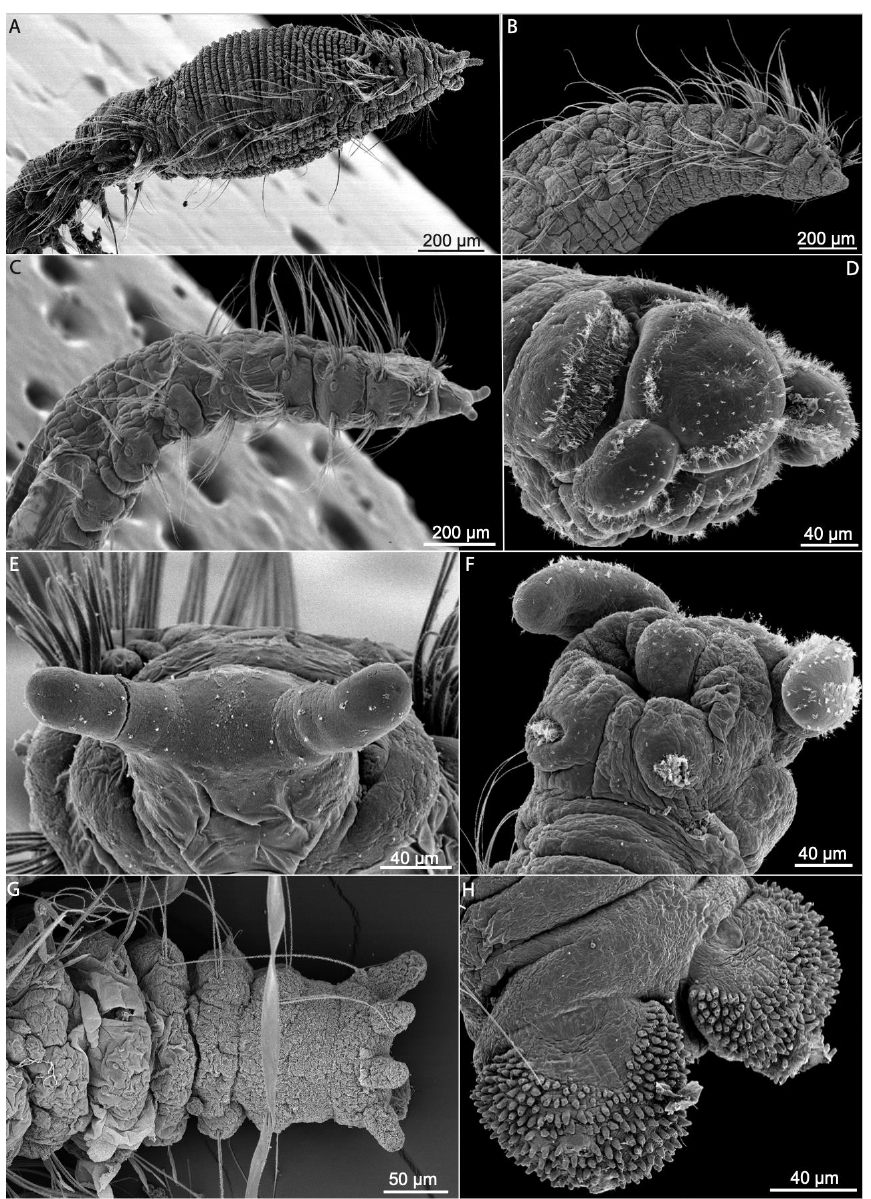
Figure 11. SEM micrographs of several Scalibregmatidae showing main diagnostic characters. ( A ) Pseudoscalibregma sp., Canary Islands, anterior end in lateral view; ( B ) Asclerocheilus sp., northwestern Spain, anterior end in lateral view; ( C ) Asclerocheilus sp., Canary Islands, anterior end in lateral view; notice the different morphology and epidermal pattern found on the anterior end on A – C. ( D ) A. cavernicola, anterior end in lateral view; ( E ) Asclerocheilus sp., Canary Islands, anterior end in frontal view, compare the arrangement of the ciliary patterns between D and E; ( F ) A. cavernicola, anterior end in ventral view, showing the ventral ciliary pads pn the peristomium; ( G ) Asclerocheilus sp., northwestern Spain, posterior end in dorsal view, showing a typical shape and arrangement of the pygidium in Scalibregmatidae; ( H ) A. cavernicola , posterior end in dorsal view, showing the adhesive pygidium typical of the genera Axiokebuita and Speleobregma